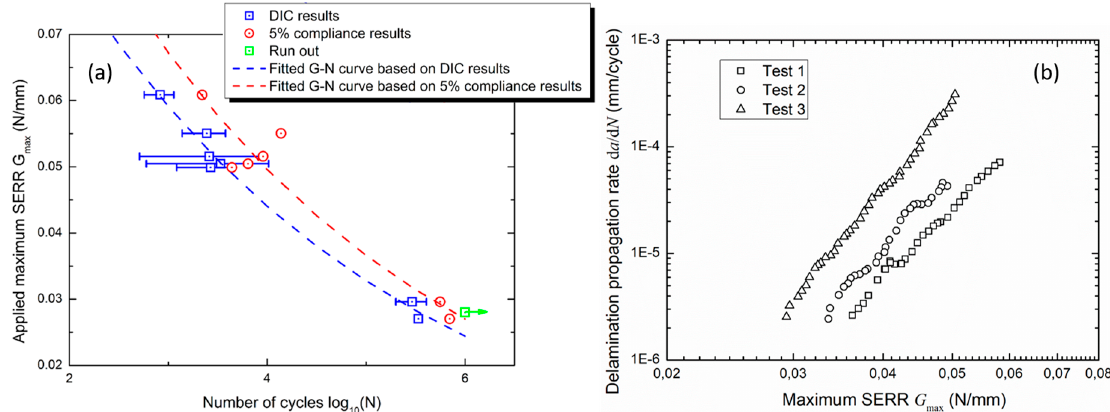
Figure 3. Mode I delamination: ( a ) G-N curves from DIC method and compliance method; ( b ) fatigue delamination propagation rate